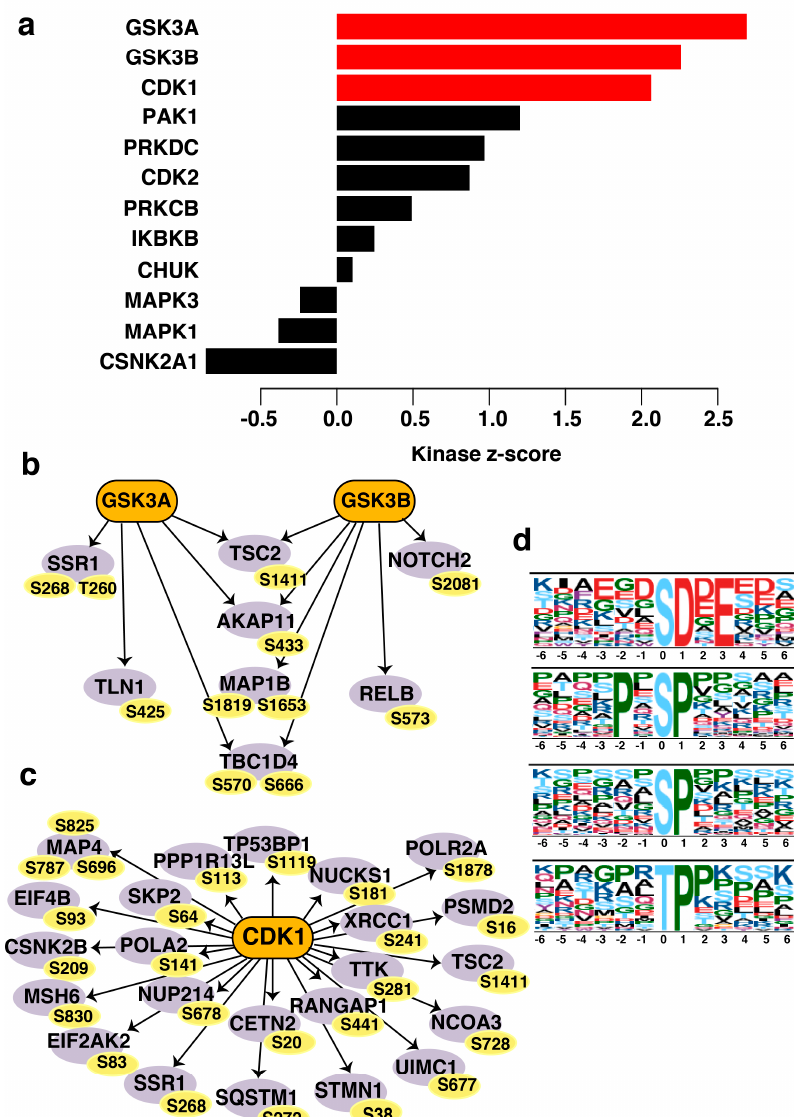
Figure 6. ( a ) Predicted upstream kinases enriched in the non-type subtype of bladder carcinoma cell lines. Graph showing the positively regulated upstream kinases (red bars) predicted to be activated in the non-type subtype. ( b ) Substrates of GSK3A / 3B and ( c ) CDK1 enriched in non-type molecular subtype depicted by a schematic diagram. The respective phosphosites of the substrates identified are also highlighted. ( d ) Motif analysis of di ff erentially phosphorylated peptides of non-type subtype bladder carcinoma. Serine and threonine motifs identified in the non-type subtype of bladder